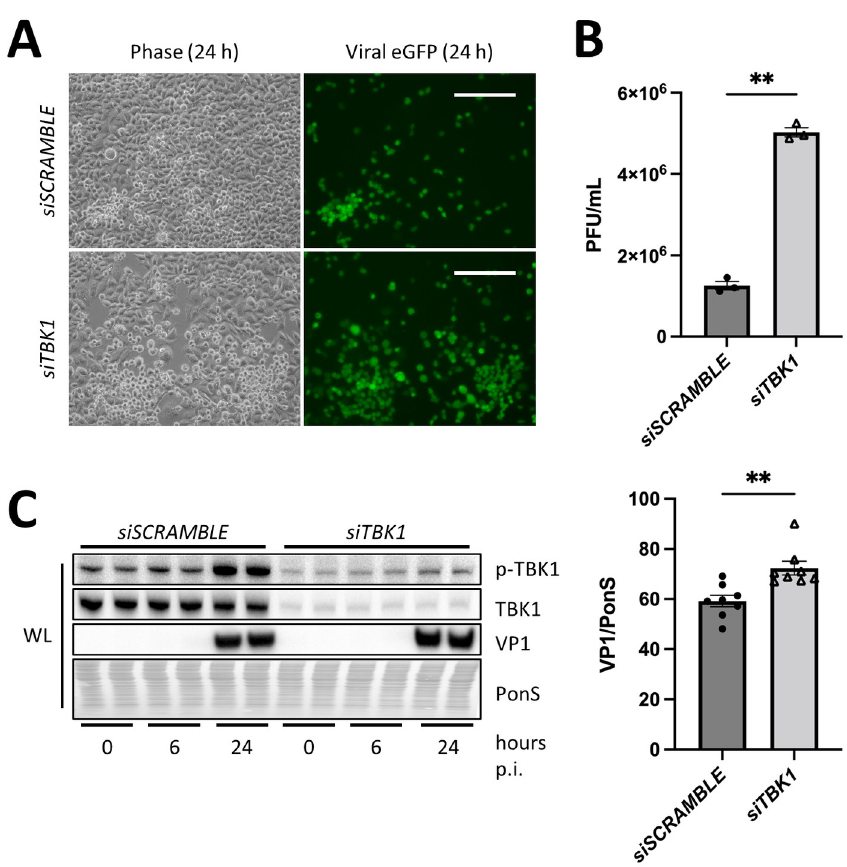
Fig 2. Silencing TBK1 increases CVB infection. HeLa cells were treated with siRNA targeting TBK1 ( siTBK1 ) or scrambled RNA ( siSCRAMBLE ) and subsequently infected with eGFP-CVB at MOI 0.01. (A) Fluorescence microscopy of infected HeLas at 24 h postinfection (p.i.). Phase contrast images show similar cell density at 24 h p.i. Scale bars represent 100 μ m. (B) Extracellular viral titers of infected cells at 24 h as measured by plaque assay. �� , p < 0.01, Student t test; n = 3. (C) Western blots of infected cells at 0 h, 6 h, and 24 h p.i. including densitometry. A representative Western blot is shown. �� , p < 0.01, Student t test; n = 8. Data are representative of 4 experiments. WL = whole